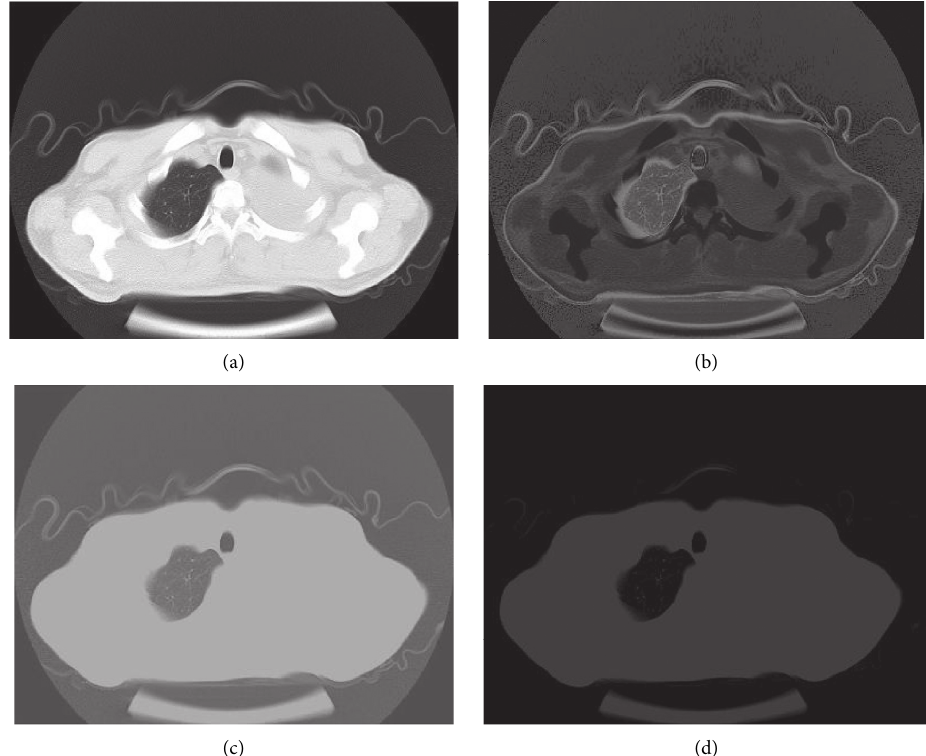
Figure 7: Comparison of algorithms under different feature images: (a) original image; (b) SURF; (c) gray texture feature; (d) fusion feature method.